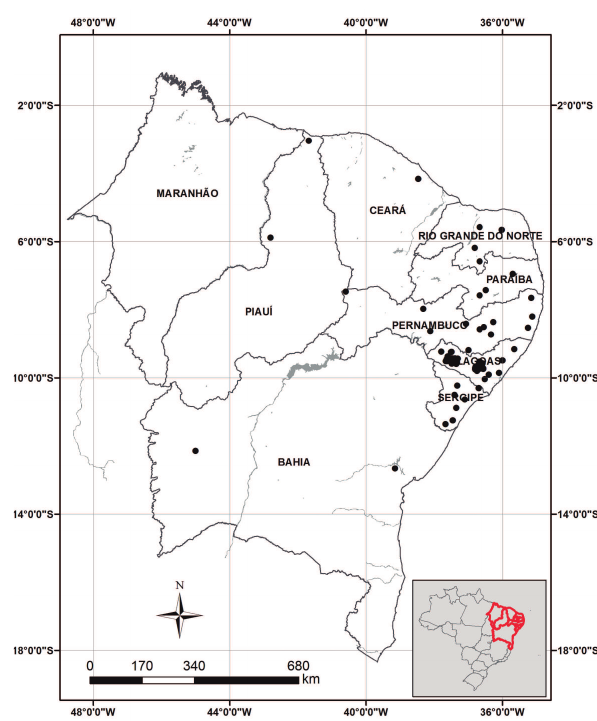
Figure 1. Northeastern region of Brazil (inset: Brazil) showing locations where data of water retention and PTF estimators sand, clay, organic matter contents and bulk density were